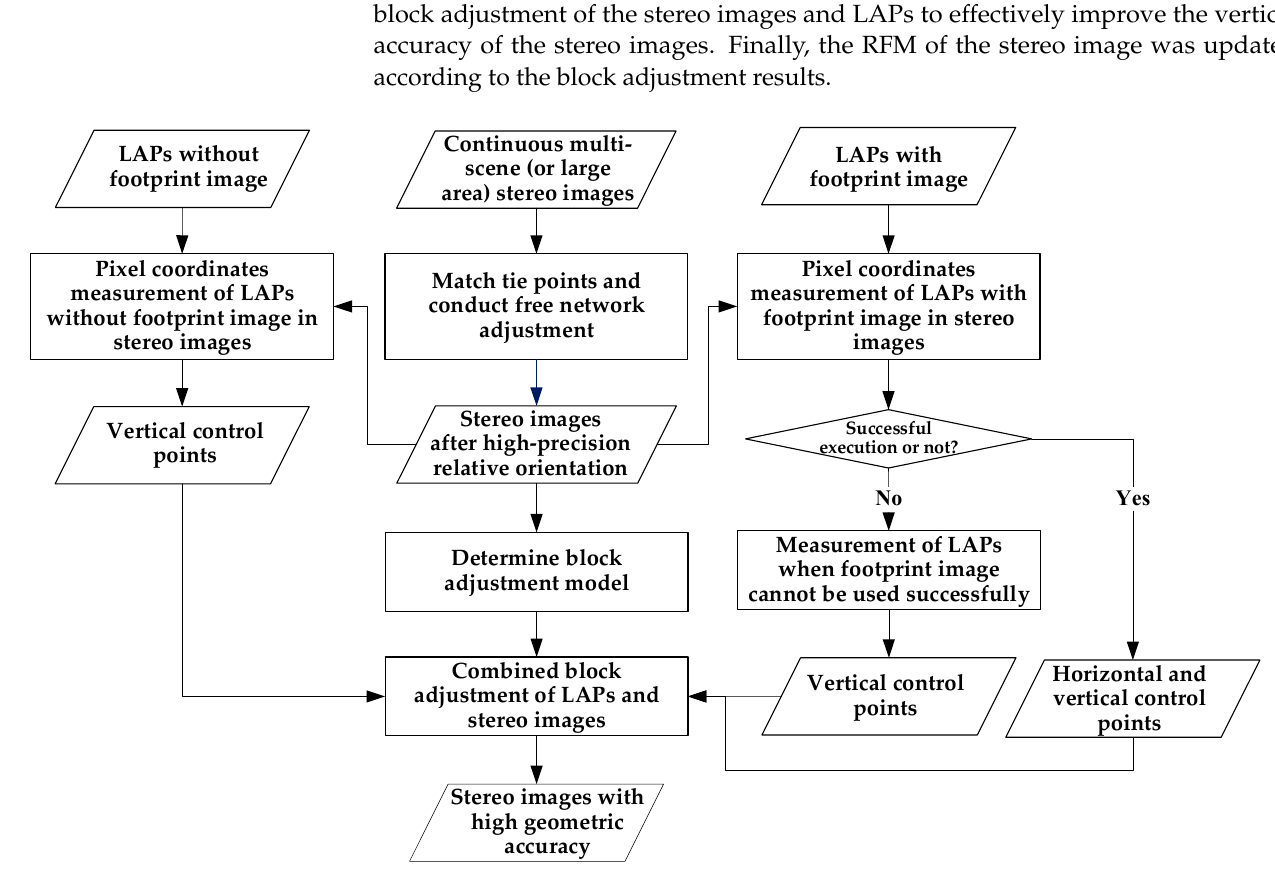
Figure 2. Integrated processing flow for the LAPs and stereo images.